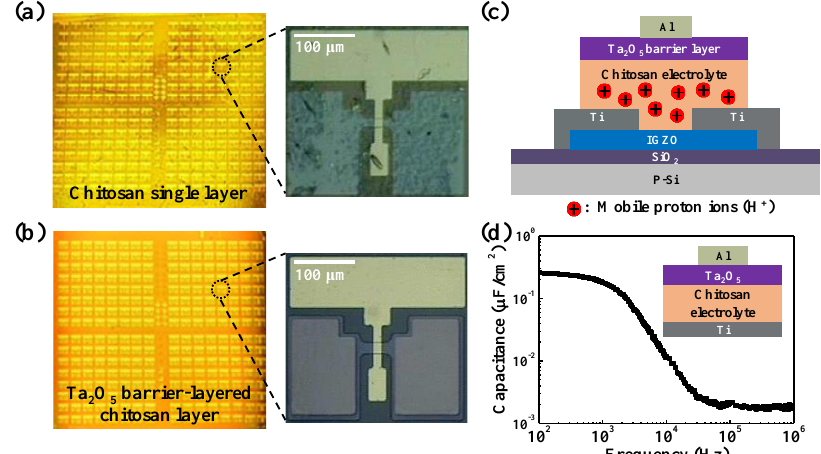
Figure 1. Optical microscope images of synaptic transistors fabricated by photolithography patterning process gated by ( a ) single chitosan layer and ( b ) high- k Ta 2 O 5 barrier-layered chitosan layer; ( c ) cross-sectional schematics of Ta 2 O 5 –chitosan EDL transistor. ( d ) Frequency-dependent specific capacitance of the Ta 2 O 5 –chitosan electrolyte EDL